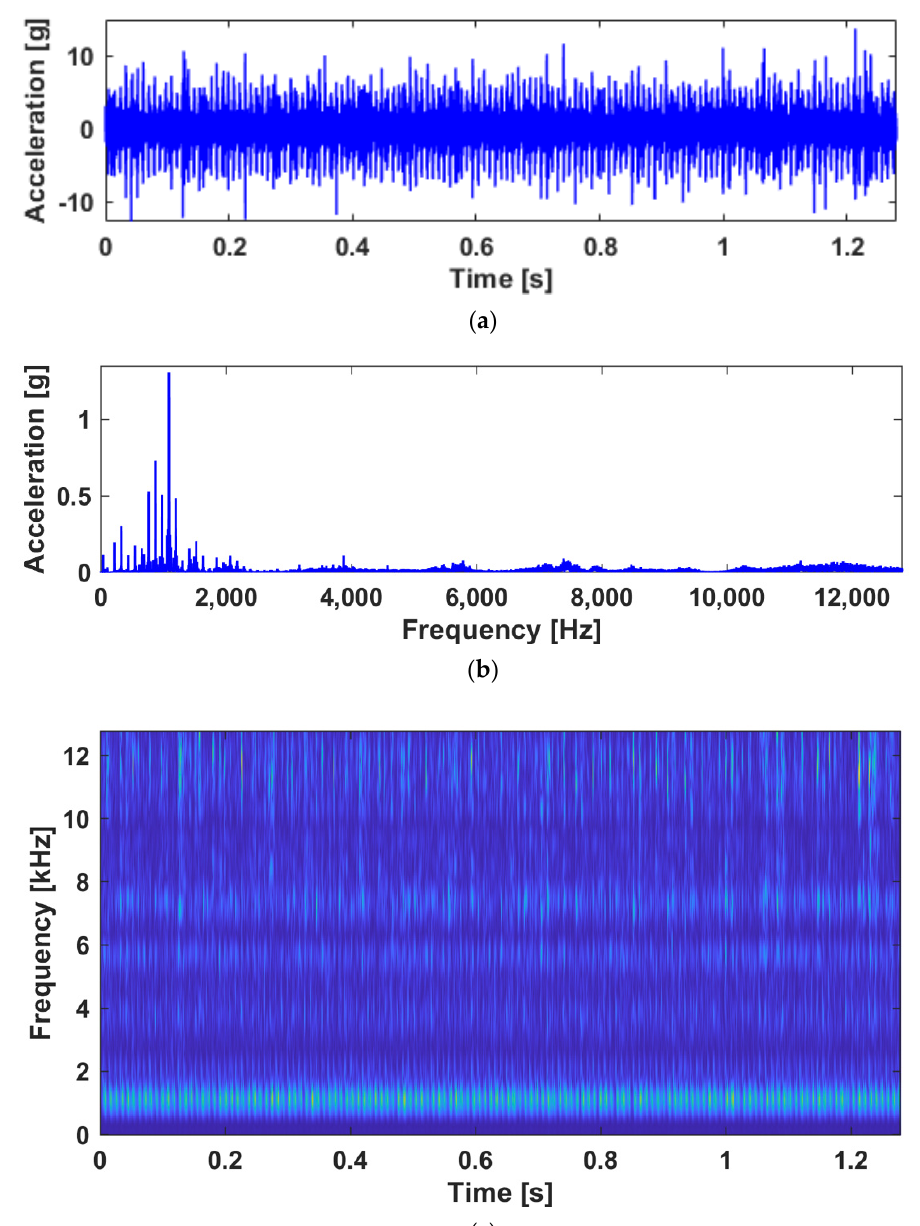
Figure 12. ( a ) The horizontal acceleration signal, ( b ) the amplitude spectrum, and ( c ) the correspond- ing STFT spectrogram in Case C.